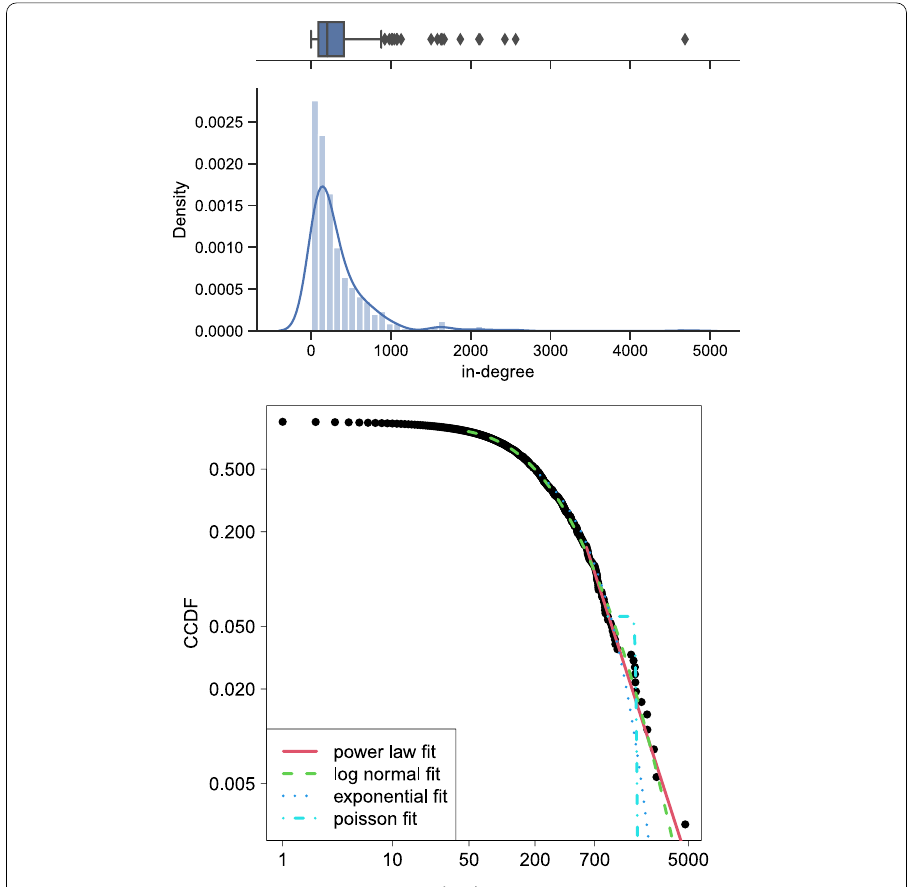
Fig. 3 I nstancEs in-degree distribution: boxplot and Probability Density Function (top), and Complementary Cumulative Distribution Function, with various distribution fittings